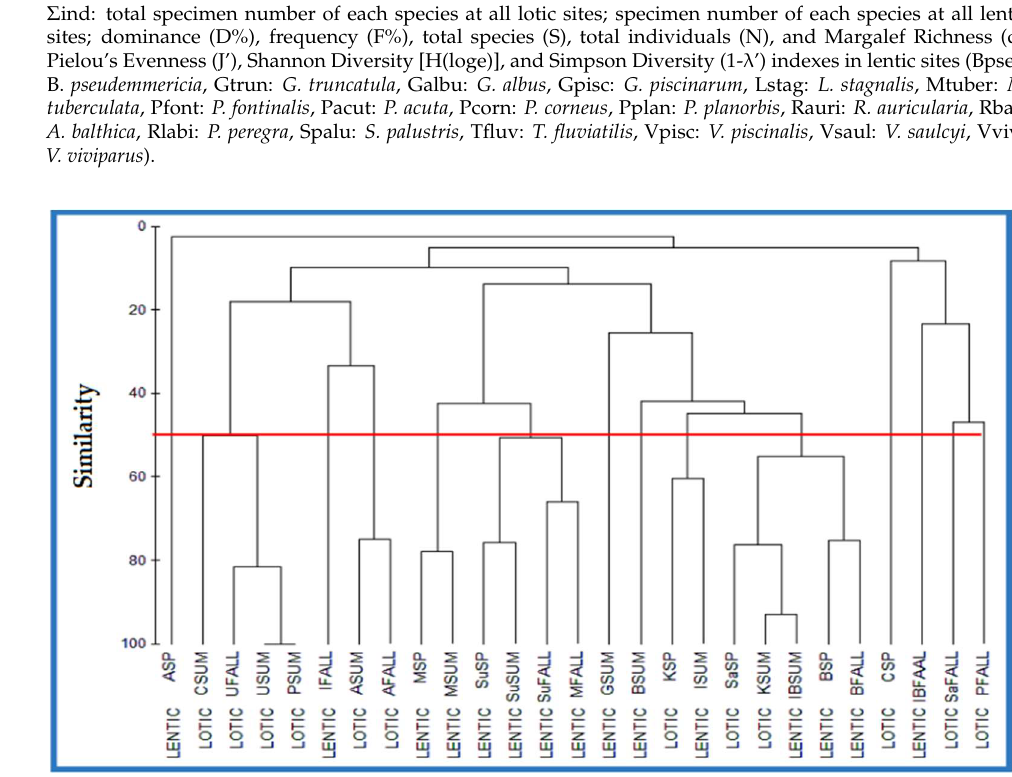
Figure 4. nMDS results of lotic and lentic sites (green triangles: lotic sites-A: Aksaray; C: Çeltik; U: Üstünler; P: Peçeneközü; Sa: Sarısu; K: Konya Centre; yellow triangles: lentic sites-A: Akkaya; IB: İbrala; I: İvriz; M: Mamasın; Su: Suğla; G: Gödet; B: Beyşehir; SP: Spring; SUM: Summer; FALL: Autumn). 3.2. In Lotic Stations Thirteen species were identified (NISP: 203). The number of individuals and species was low (Table 4). When examining the diversity, low values with an even distribution were determined for all but Üstünler and Peçeneközü. Konya Center and Peçeneközü